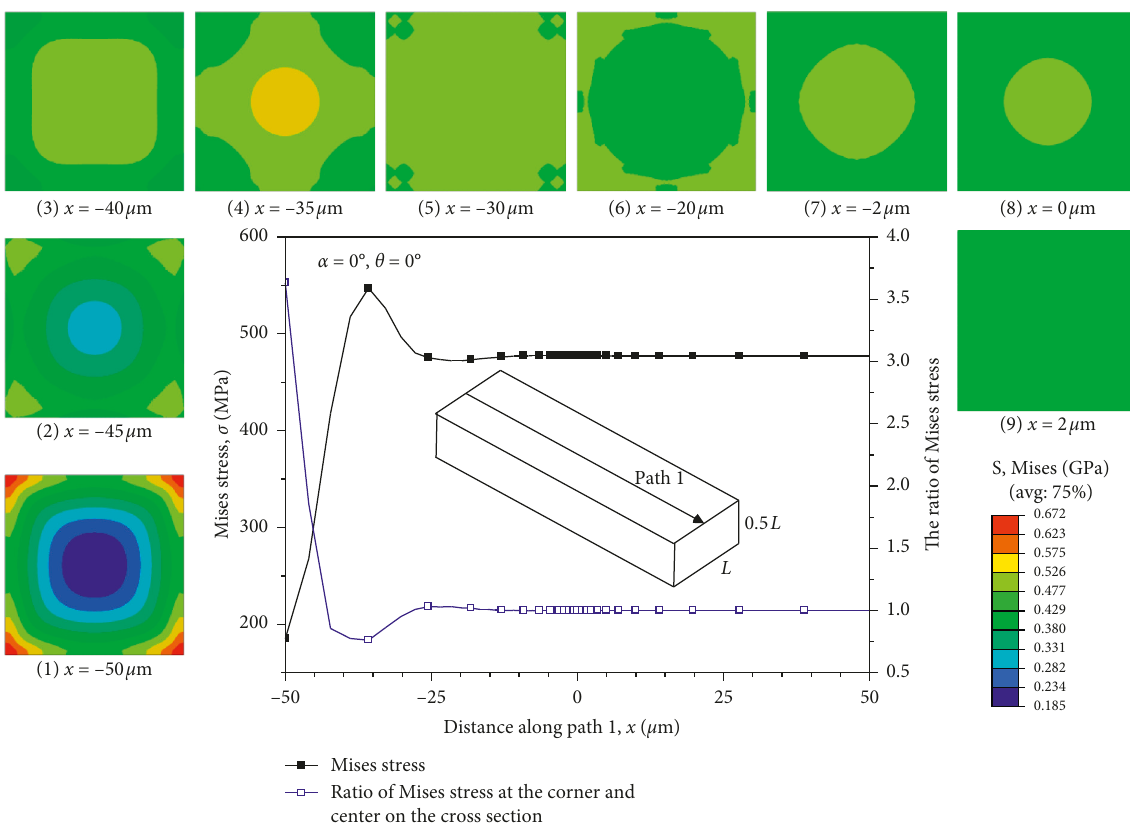
Figure 8: Stress distribution in a single crystal beam.